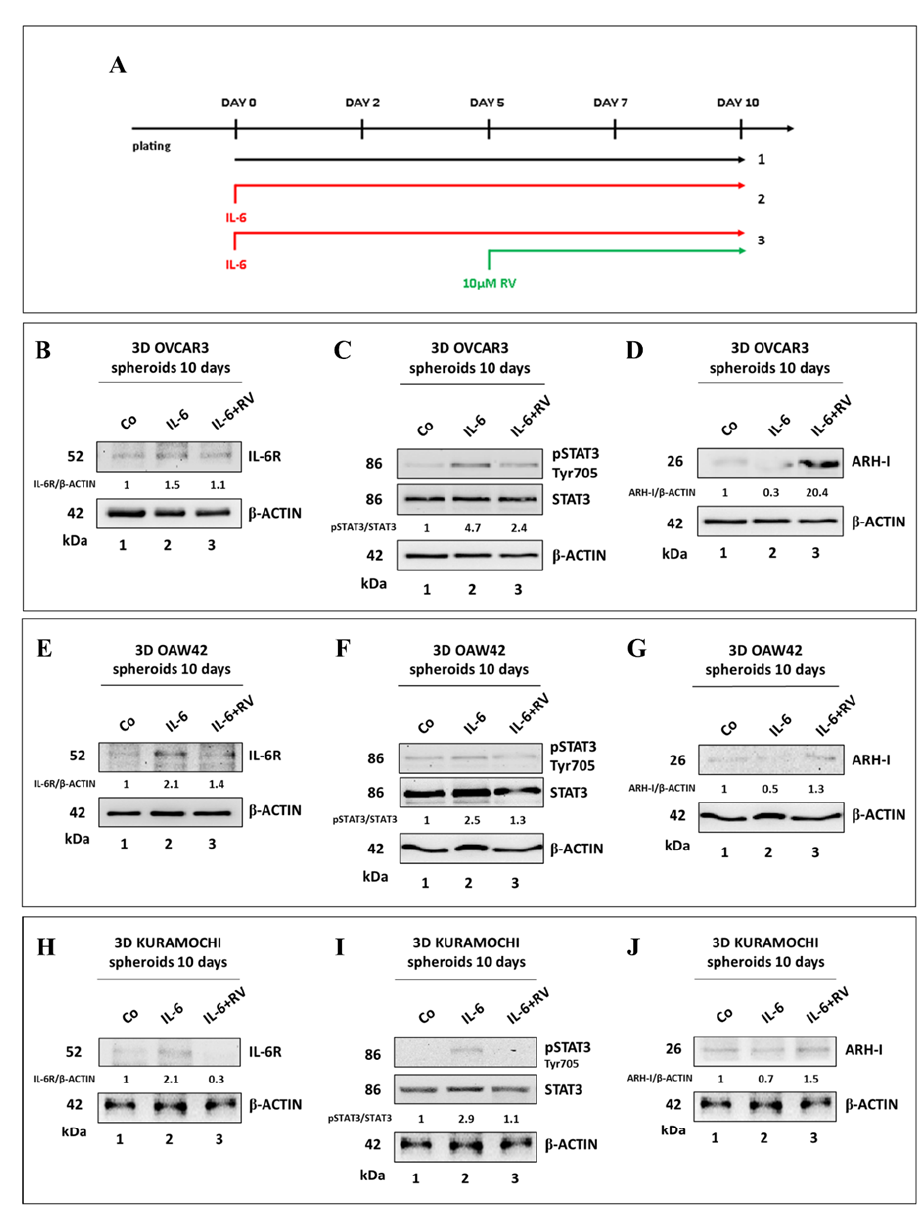
Figure 2. Resveratrol counteracts IL-6-induced IL-6R/STAT3 signaling. ( A ) Experimental time- line of 3D spheroids-forming assay. ( B , E , H ) Western blotting showing the expression of IL-6R in OVCAR3, OAW42, and KURAMOCHI 3D spheroids. ( C , F , I ) Western blotting showing the expression of pSTAT3 (Tyr705)/STAT3 in OVCAR3, OAW42, and KURAMOCHI 3D spheroids. ( D , G , J ) Western Blotting showing the expression of ARH-I in OVCAR3, OAW42, and KU- RAMOCHI 3D spheroids. The densitometric analysis of the Western blotting representative of three independent experiments is